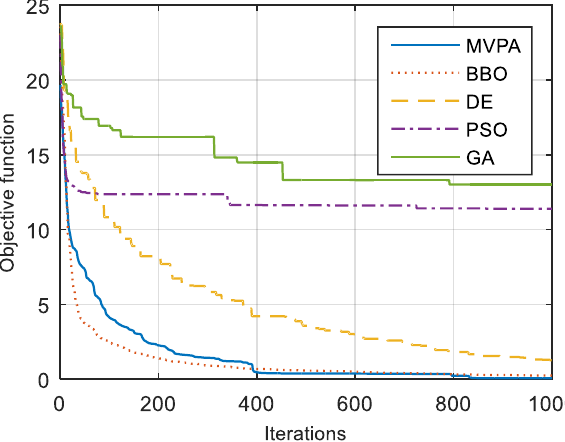
Figure 7. Evolution of the objective function versus iterations for case 3.